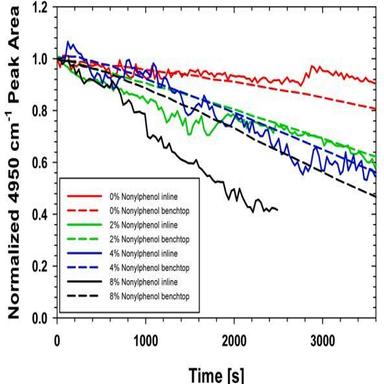
Comparison of cure kinetics as measured by inline (solid lines) and benchtop (dashed lines) FTIR spectroscopy for the Epon 828/MXD system with varying concentrations of nonylphenol.